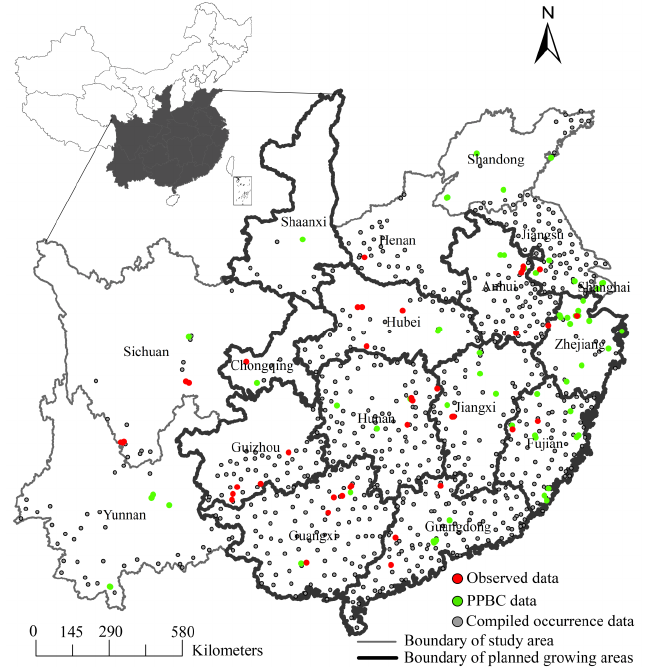
Figure 1. Map of the study area. The locations of Sapindus mukorossi observances are shown as